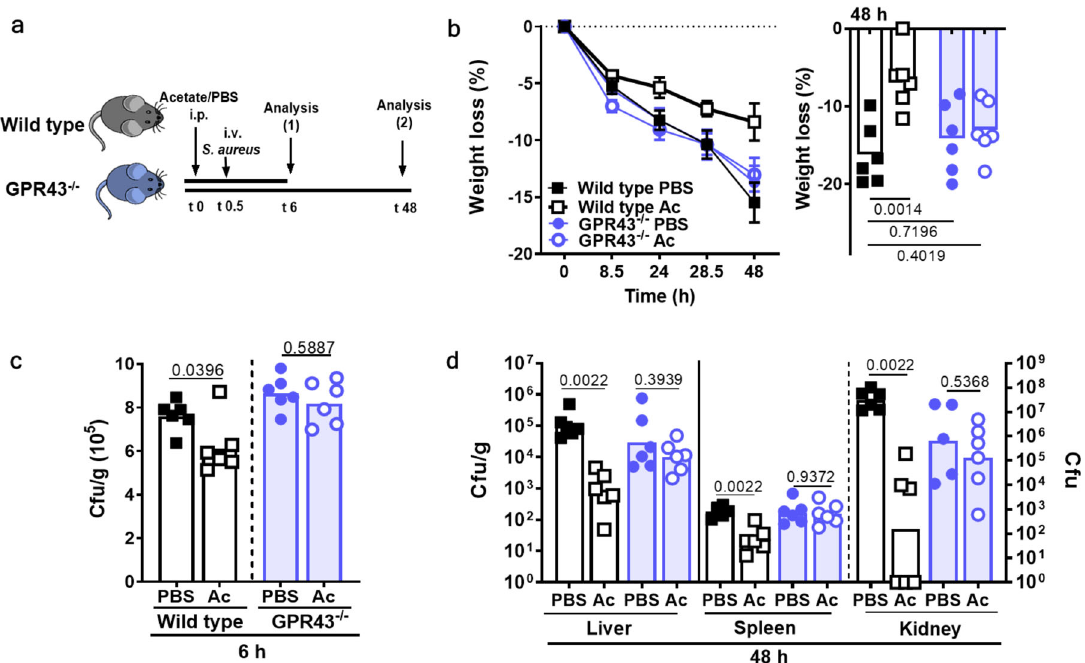
Fig. 5 GPR43-dependent acetate priming is bene fi cial during S. aureus bloodstream infection. a Treatment of mice with acetate (Ac) 30 min prior to S. aureus i.v. injection resulted in b decreased weight loss in wild-type mice (black symbols) but not in GPR43 − / − mice (blue symbols). c Six hours after infection onset, bacterial loads were slightly reduced in the liver of acetate-treated wild-type mice (black), whereas acetate showed no such effect in GPR43 − / − mice (blue). d After 48 h, acetate (Ac) treatment prior to the onset of bloodstream infection resulted in drastically decreased bacterial loads in the liver, spleen, and kidney in wild-type mice, while no such difference was observed in GPR43 − / − mice (blue). Data in b – e panels represent geometric means or geometric means± SEM ( b ) from six animals. * P < 0.05; **P < 0.01 signi fi cant difference versus the indicated PBS control as calculated by one- way ANOVA with Dunnett ’ s multiple comparisons test ( b ) and Mann – Whitney U test ( c and d